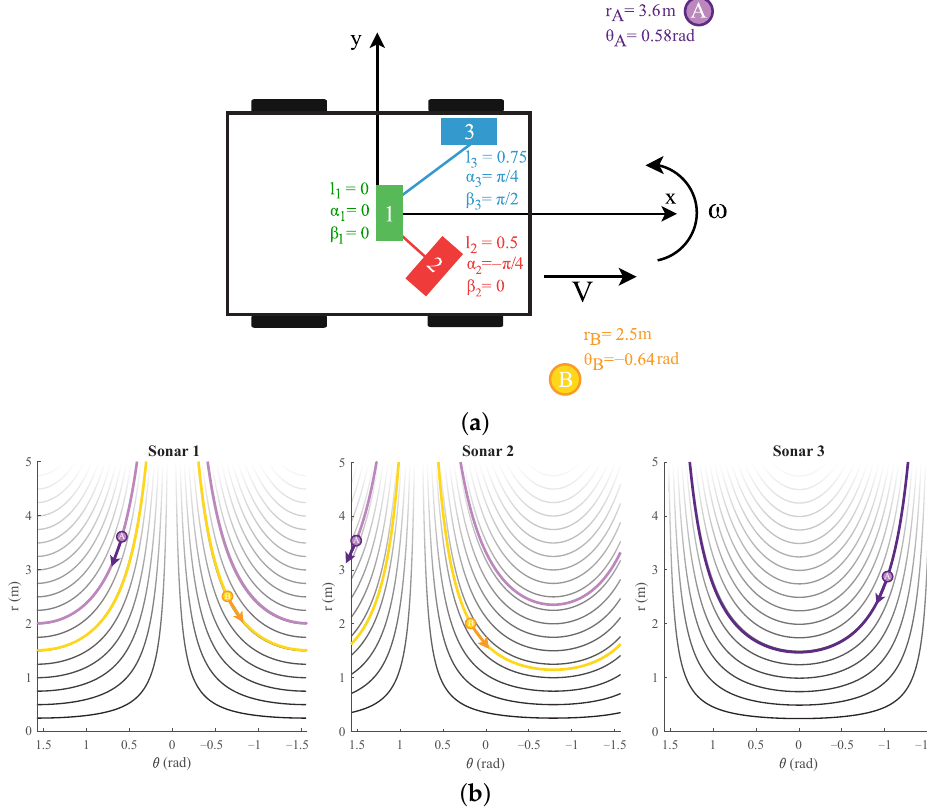
Figure 4. ( a ) A mobile platform seen from the top with three sonar sensors. The ( α , β , l ) parameter values are shown as well. Next to it, two reflecting objects exist, defined as A and B with their ( r 0 , θ 0 ) coordinates. The placement of these reflectors in the figure is not accurate or to scale. ( b ) The ( r ( t ) , θ ( t )) flow-lines of reflections A and B for a positive linear motion V are marked for sonar sensors 1, 2, and 3 of Figure 4a. The arrow indicates the direction the reflection would move with such a motion. The flow-lines for other distances falling in range ( r ∈ [ 0; r max ] ) are also shown, with r max being the maximum detected range of the eRTIS